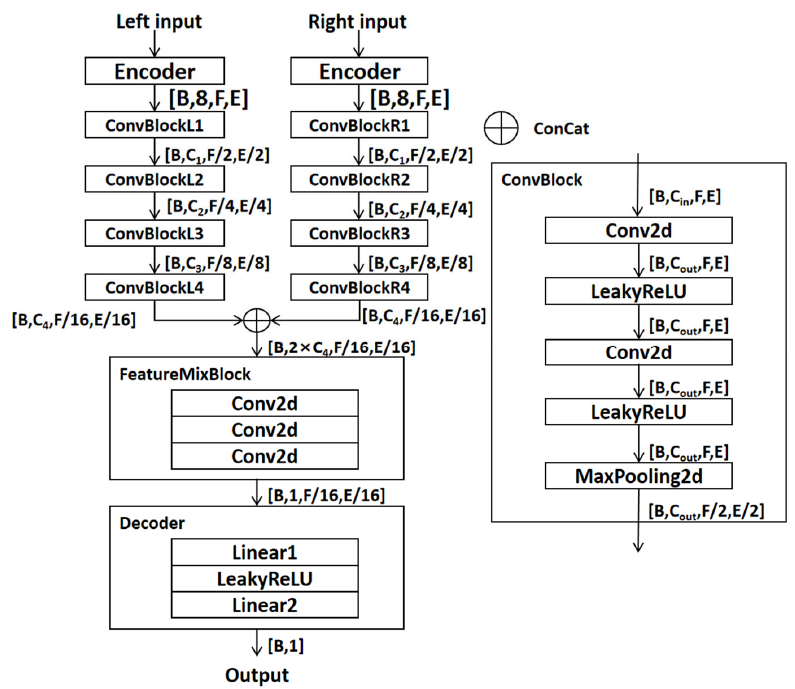
Figure 2. Model architecture. The left is the whole process, and the right is the detail of ConvBlock.